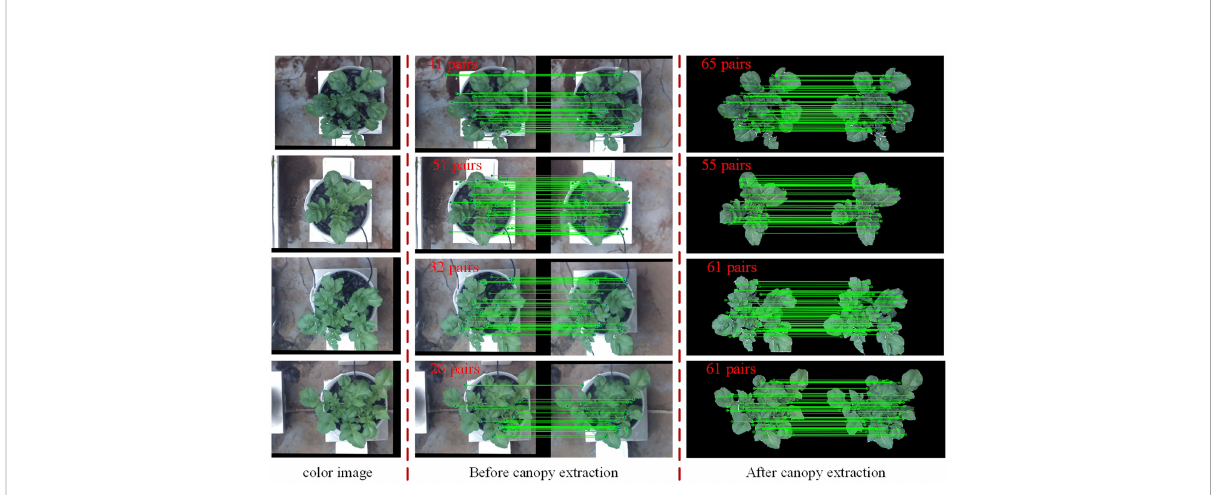
FIGURE 7 Comparison of the number of feature points obtained by detection, matching and fi ltering before and after canopy